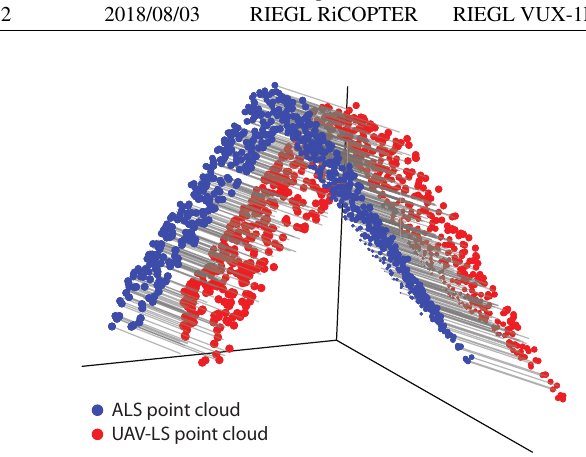
Figure 5. Principle of the segment-based ICP-Matching